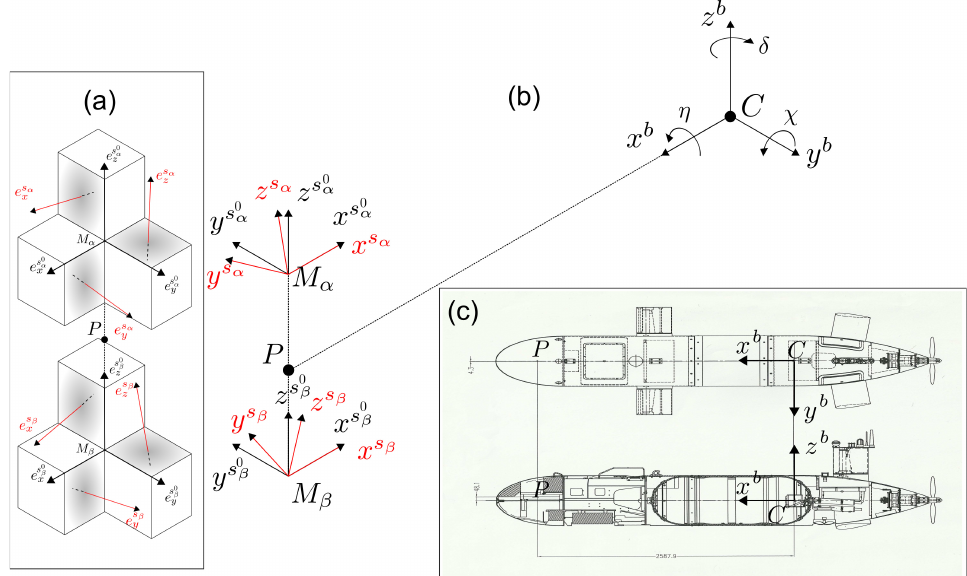
Figure A2. ( a ) View of triplets of unit vectors (in red) which defined respectively the sensor reference (cid:16) (cid:17) (cid:0) (cid:1) s β s β s β e s α x , e s α y , e s α z e frames for the triads α (top) and β (bottom) . The shaded areas indicate the x , e y , e z arrangement of the accelerometers in the two parallelepiped triads. The misalignment angles have been deliberately exaggerated to make the figure easier to read. The corresponding triplet of unit, mutually orthogonal vectors (in black) which defined the orthogonal sensor frames for the triads α (top) and β (bottom) are also represented. ( b ) View of relative positions of points C (AUV reference point), P (GraviMob’s sensitive point), M α and M β (centres of α and β triads respectively) in the s -frame and b -frame reference frames are also given. ( CP ) is the AUV. The locations of s α , s o α , s β , s o β revolution axis of the AUV (roll axis). The angles η , χ , δ are repectively the roll, pitch and yaw angles. −→ −→ −→ CP , PM α and PM β can be considered as lever arms. ( c ) Location It should be noted that the vectors of the b -frame ( Cx b y b z b ) in the AUV. The revolution axis ( CP ) can also be